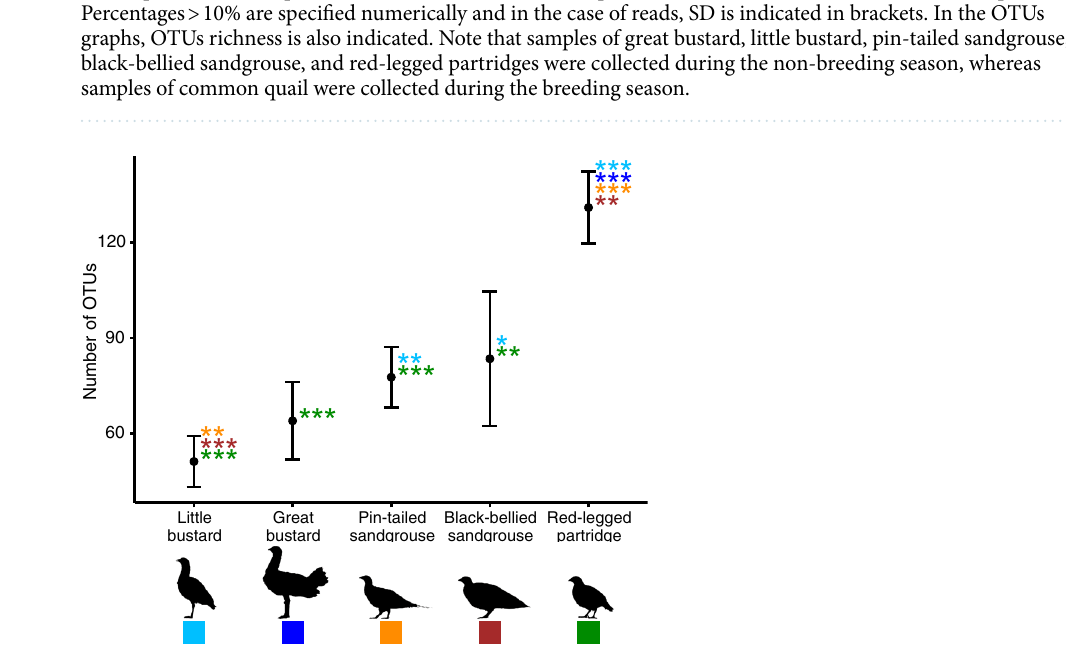
Figure 3. OTUs richness in the diet of studied species. The whiskers represent the 95% confidence intervals. The statistical significance of the Tukey post-hoc test is provided by * symbols. *** P < 0.001. ** P < 0.01. * P < 0.05. The colour of the * corresponds to the colour of the species with which the comparison is made. For those comparisons that were not statistically significant, no significance data are provided. For detailed statistical results of Tukey post-hoc tests, see Supplementary Table S2